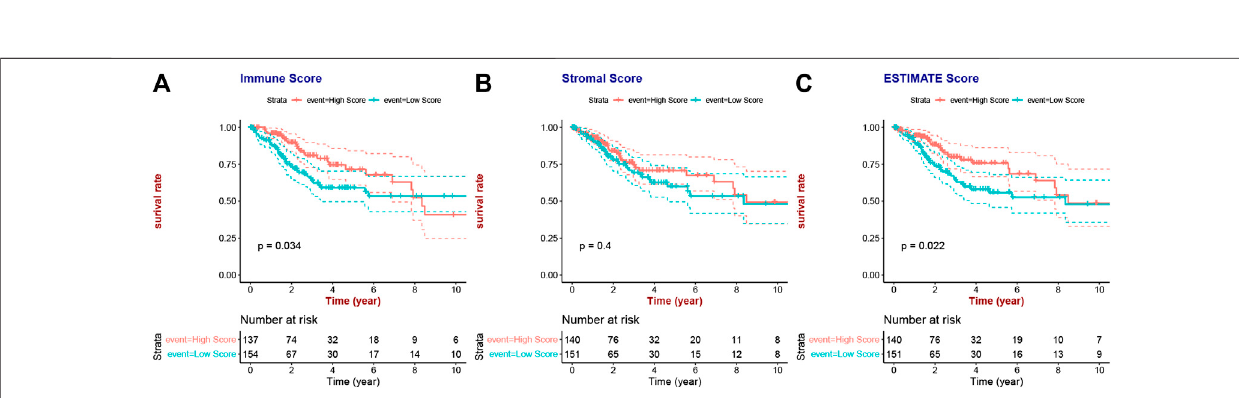
Frontiers in Molecular Biosciences |